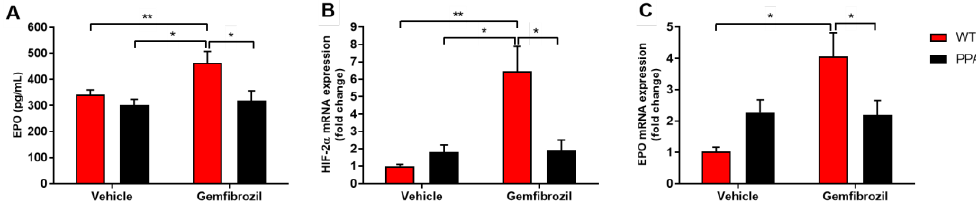
Figure 2. Gemfibrozil treatment increased renal erythropoiesis. Serum erythropoietin (EPO) levels ( A ) were increased with gemfibrozil treatment. Renal hypoxia-inducible factor-2 alpha ( HIF-2 α ); ( B ) and EPO ; ( C ) mRNA levels also increased after gemfibrozil treatment. Data are presented as mean ± SEM; n = 5–6 per group. Two-way ANOVA followed by Tukey’s post hoc test. * p < 0.05; ** p < 0.01.